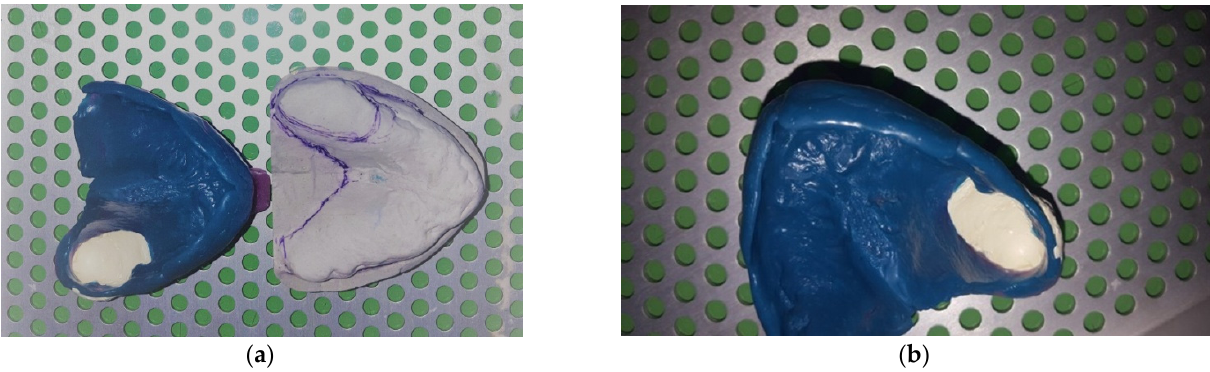
Figure 2. ( a ) Preliminary cast and final impression of a V-shaped maxillary prosthetic field, with high retentive ridges, deep palatal vault, retentive tuberosity, with flabby mucosa; ( b ) detail of the upper jaw impression recorded with two low viscosity materials in two stages. The tuberosity impression was made in the resting position, without compression, by brushing the material on its surface.